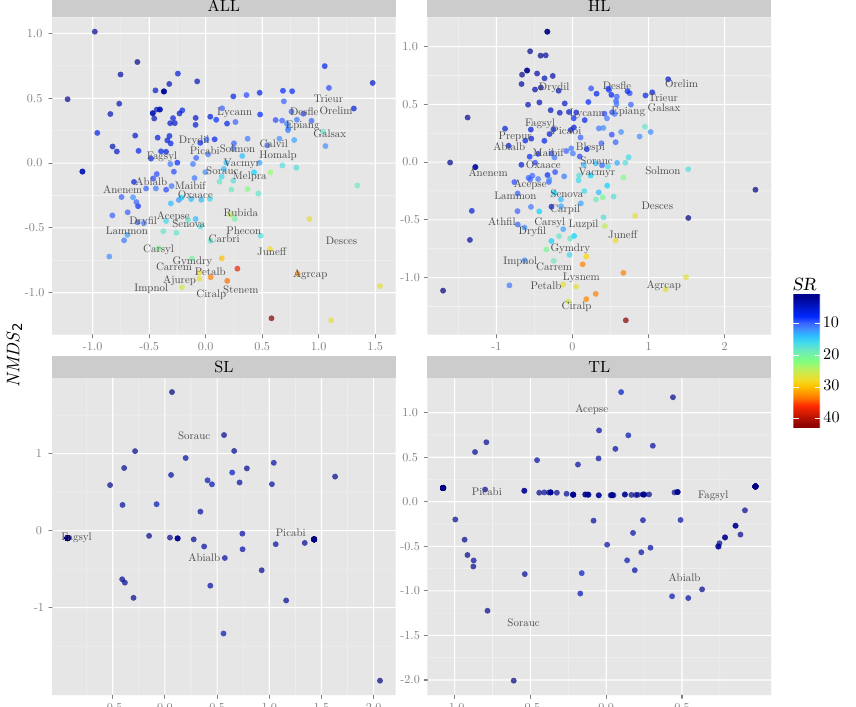
Figure 3. Bi-plot of site and species scores in NMDS space for herb (HL), shrub (SL), tree layer (TL) and their total (ALL). Species acronyms consist of the first three letters of genus and species respectively (see supplementary materials, Table S1 for decoding). Only species occurring in more than 20% of the plots are shown. Colour mapping depicts species